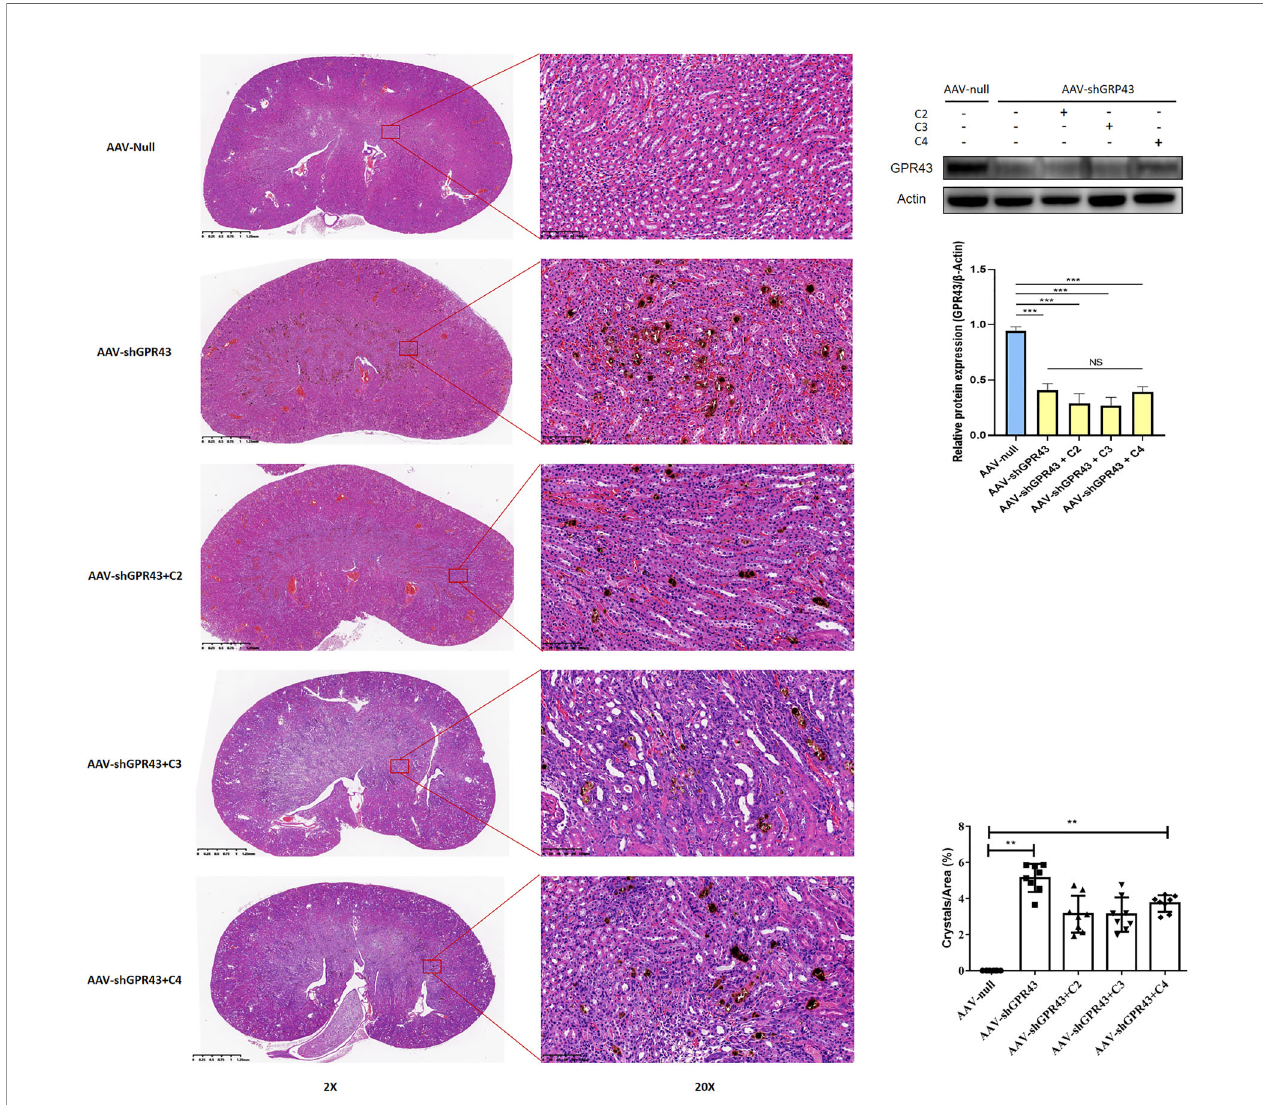
FIGURE 12 | Representative images of Von Kossa staining and HE staining in kidney after administration of AAV carrying shRNA targeting GPR43. AAV-shGPR43 represent as groups of mice treated with AAV carrying shRNA targeting GPR43 and administration with SCFAs. Western Blot was used to detect GPR43 expression on protein level. Statistically signi fi cant was shown as **p < 0.01, ***p <